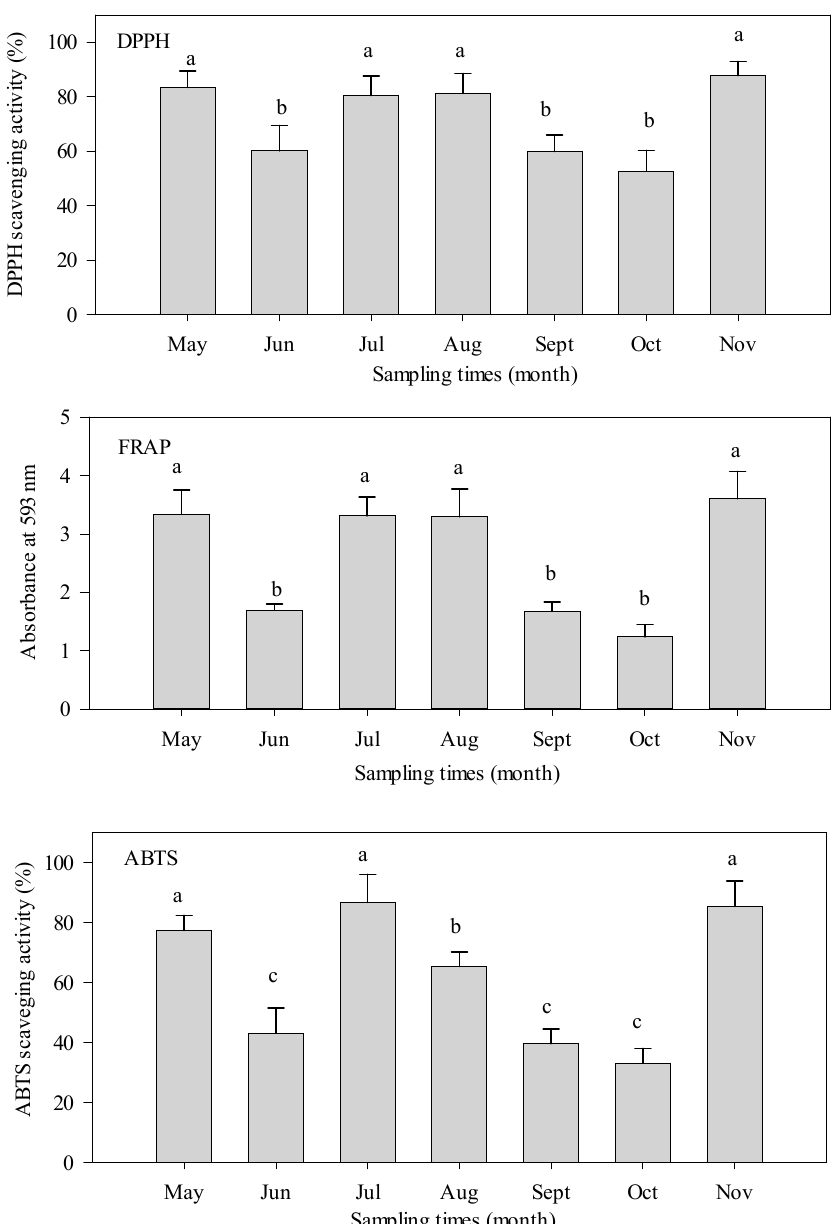
Figure 4. Seasonal variation of antioxidant activities of C. paliurus leaf extracts (mean ± SD). Different letters in this figure indicate significant differences between the sampling times for the same category according to Duncan’s test ( p < 0.05). Each value presented is the mean of triplicate of family of 4#.